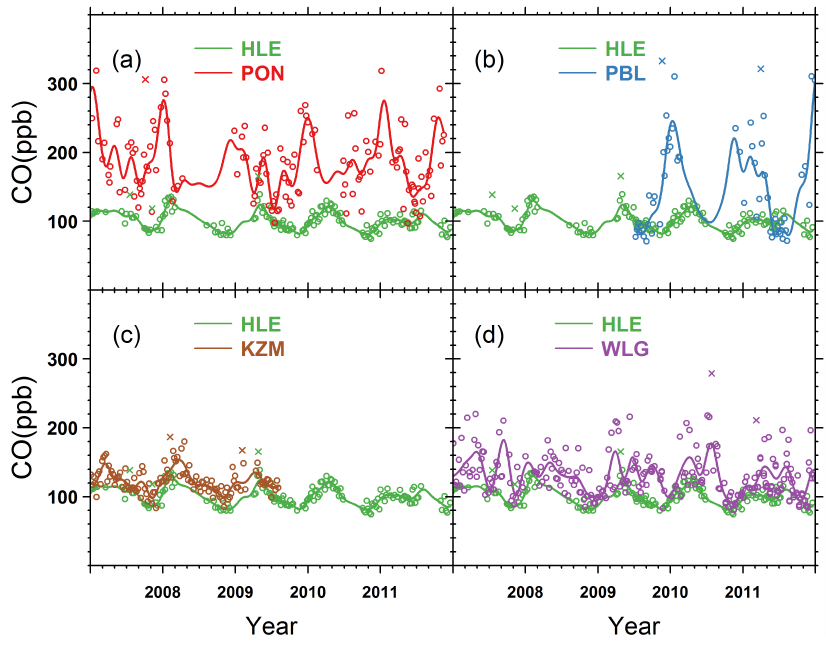
Figure 10. Time series of CO flask measurements at (a) HLE and PON, (b) HLE and PBL, (c) HLE and KZM, and (d) HLE and WLG. The open circles denote flask data used to fit the smoothed curves, while the crosses denote discarded flask data lying outside 3 times the residual standard deviations from the smoothed curve fits. For each station, the smoothed curve is fitted using Thoning’s method (Thoning et al., 1989) after removing